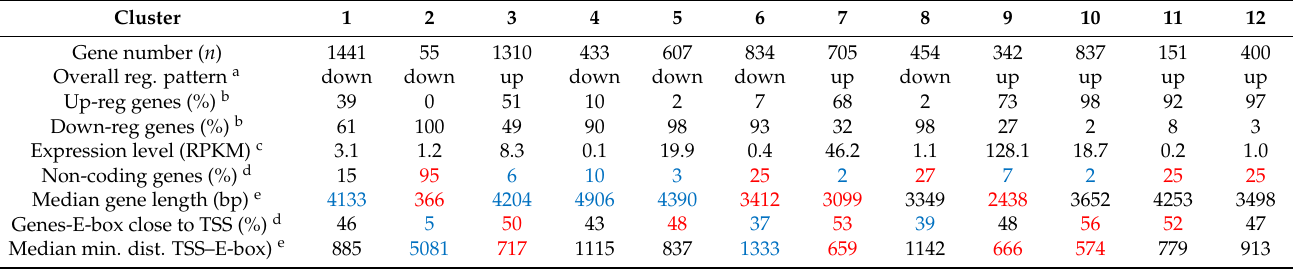
Table 1. Quantitative characteristics of MYC responsive gene clusters, clustered according to RPKM, MYC response and MYC mutant